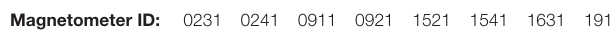
TABLE 3 | List of the IDs of the selected MEG magnetometers representative of the two classes: No-Go and